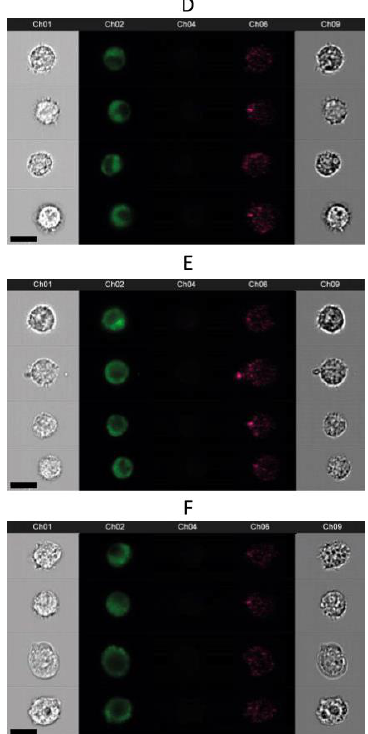
Figure 7. Uptake of T1 liposomes by RAW 264.7 macrophages presented by flow imaging. Four representative pictures are selected for the incubation time of 4 (panel B ), 6 ( C ), 12 ( D ), 18 ( E ) and 24 h ( F ) after adjusting auto-fluorescence on the negative control ( A : two upper rows). Ch01 and Ch09 exhibit bright field images, Ch02 detects the fluorophore T, Ch4 represents the PI fluorescence and Ch6 visually expresses the side scattering. A ch04-positive control is included for comparison ( A : two bottom rows). The scale bar (black bar, bottom right) is 15 µ m. Abbreviations: Ch refers to channel; PI to Propidium Iodide; T to the lipid